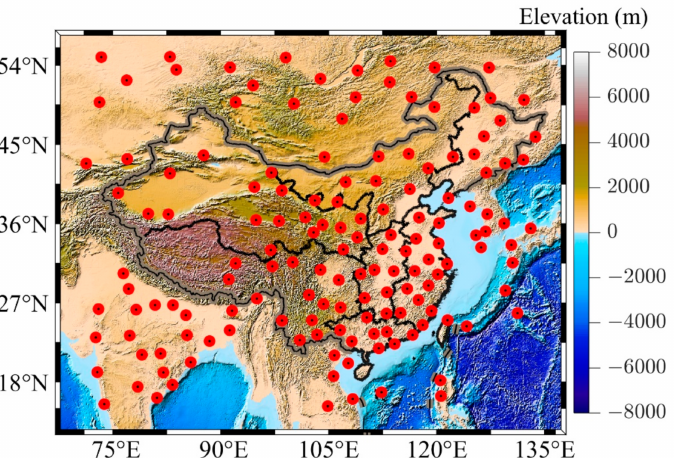
Figure 1. Topography of the study area and geographical distribution of the radiosonde stations. The red points indicate the location of the radiosonde